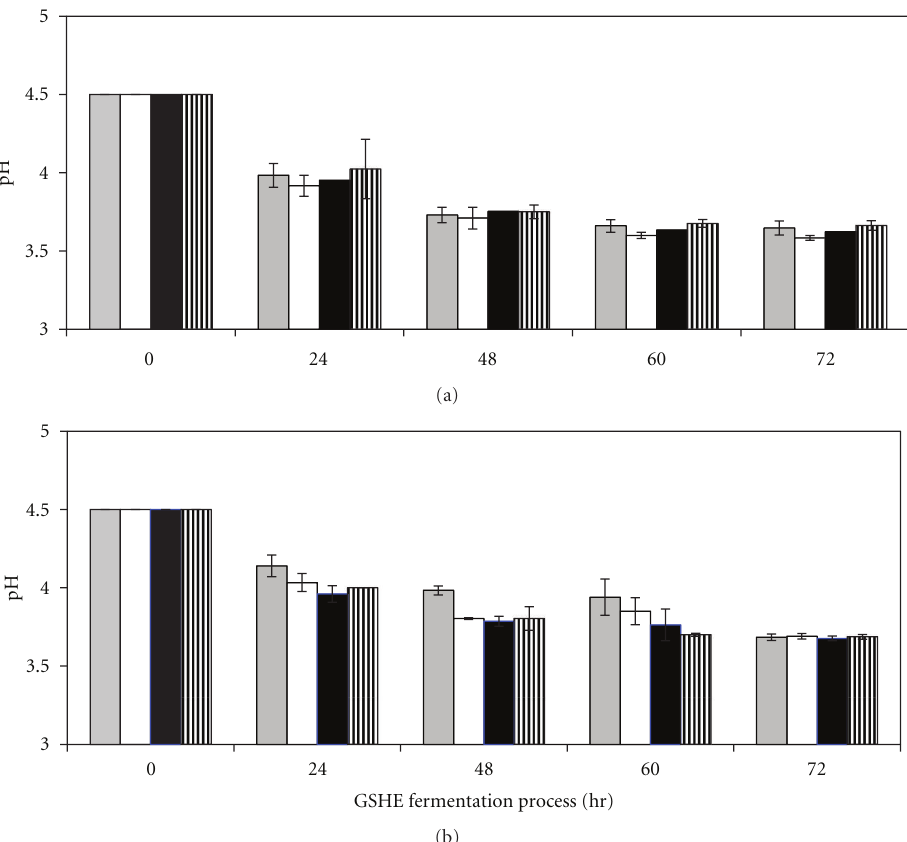
Figure 2: pH profile of GSHE, under yeast fermentation process at 32 ± 2 ◦ C at various GSHE dosage (kg/MT of grain): 1.5 (grey); 2.0 (white); 2.5 (black); 3.0 (striped) when (a) Indian broken rice; (b) Indian pearl millet was used as a raw material. The values represent means ± S.D. of three experimental